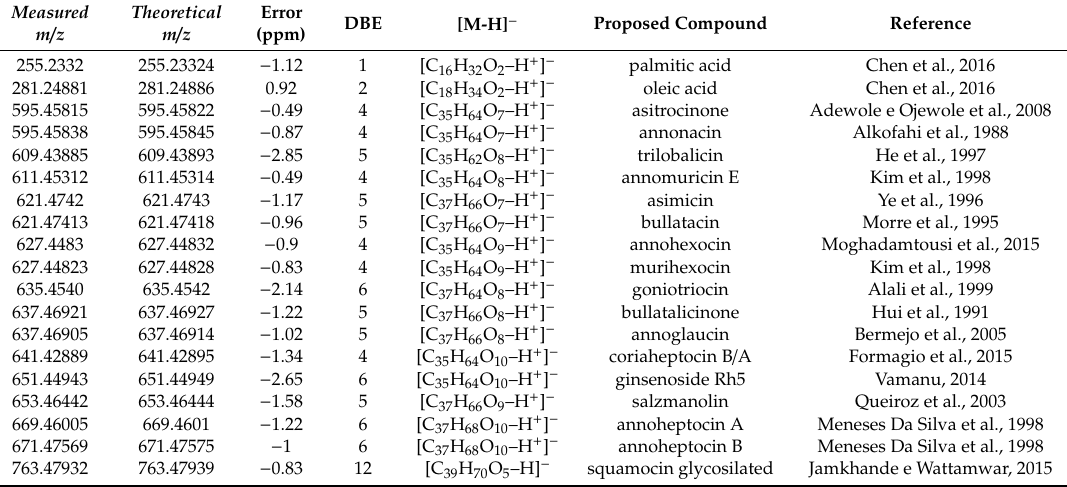
Table 1. Proposed structures by ESI (-) FT-ICR MS for the main molecules in C3 and C5 fractions from Annona coriacea.